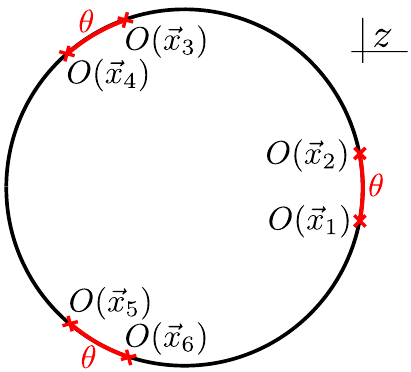
Figure 2 . The kinematics considered for the six-point function in the z plane. The black circle is the unit circle and the pairs of operators are inserted at an angle separation θ , with one pair centered at 0, one pair centered at 2 π/ 3 and the third pair centered at 4 π/ 3